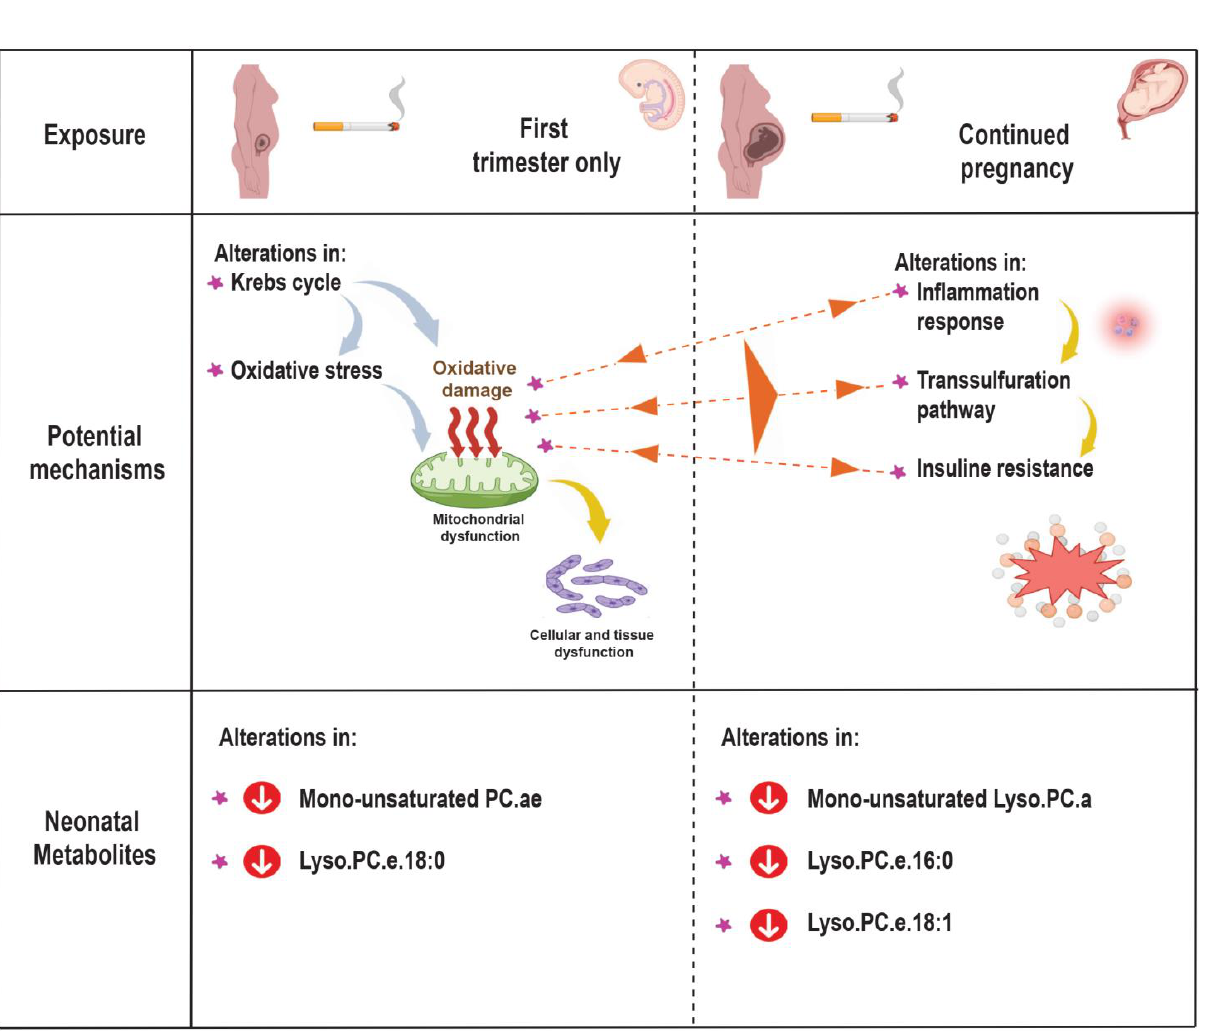
Figure 3. Potential mechanisms: Abbreviations: PC.ae, acyl-alkyl-phosphatidylcholines; Lyso.PC.a, acyl-lysophosphatidylcholines; and Lyso.PC.e, alkyl-lysophosphatidylcholines.